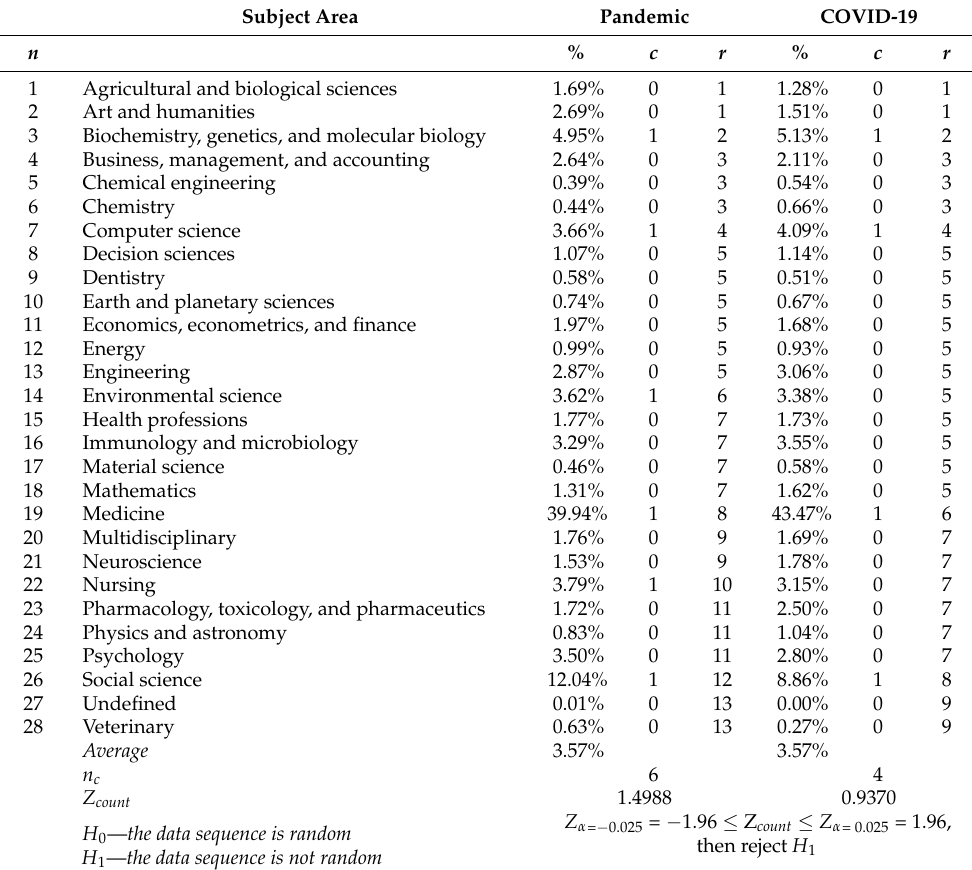
Table 1. Percentage of the number of documents in the Scopus database related to each subject area with the document title “pandemic” or “COVID-19” (accessed on July